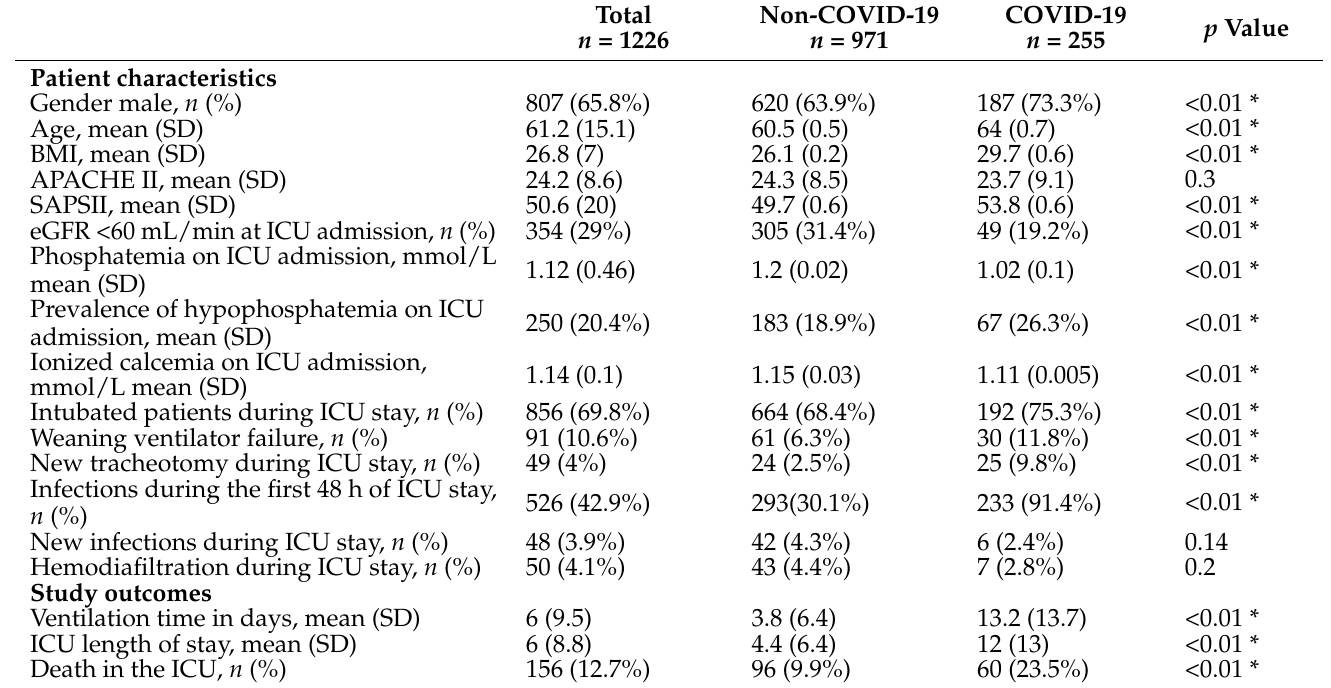
Table A1. Characteristics and differences of critically ill patients hospitalized in the ICU for non- COVID-19 and